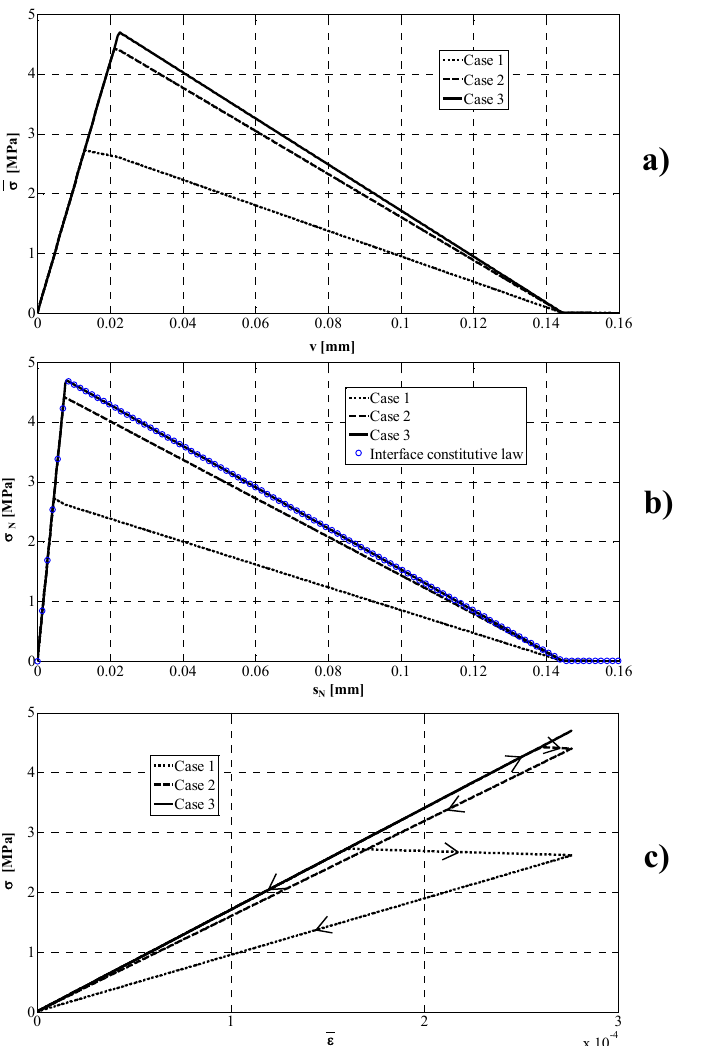
Figure 4: Numerical results obtained adopting the Model 2. a) Mechanical response of whole structure; b) Mechanical behavior of interface; c) Body tensile response.